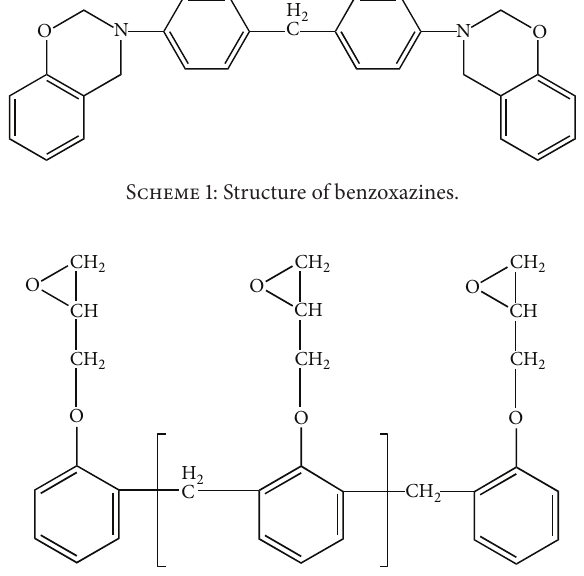
Scheme 2: Structure of novolac epoxy